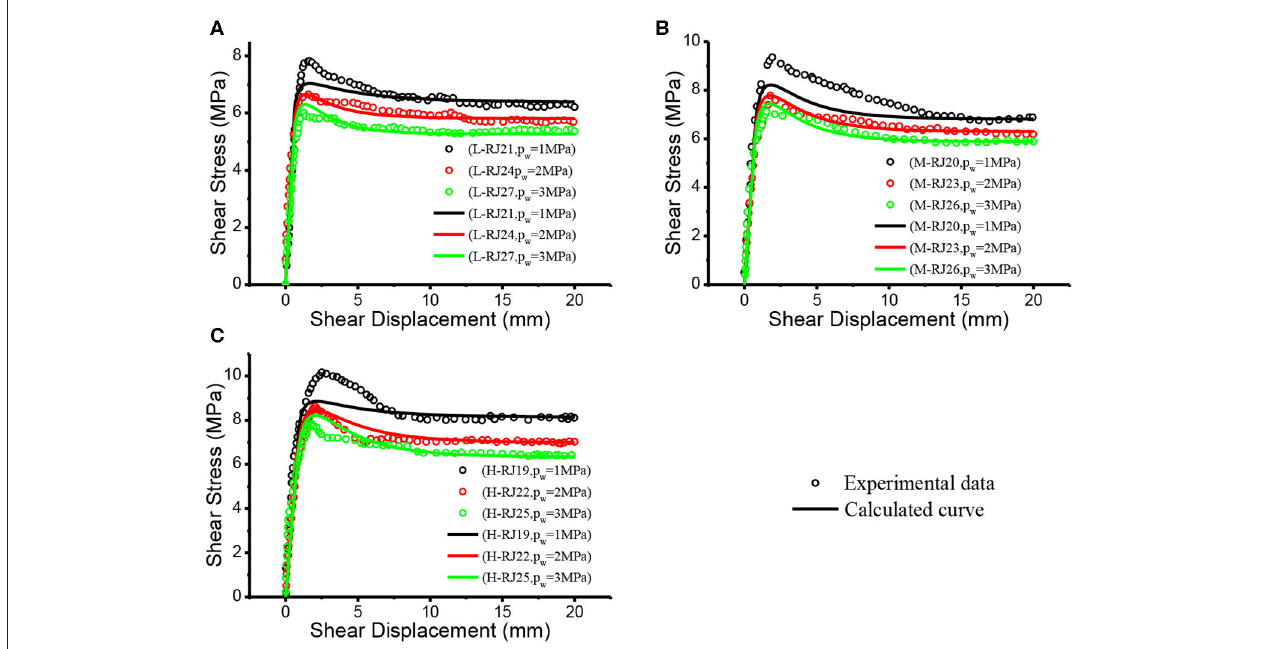
FIGURE 8 | Comparison between the calculated curve of proposed model and experimental result ( σ n = 10 MP a). (A) L joint (B) M joint (C) H